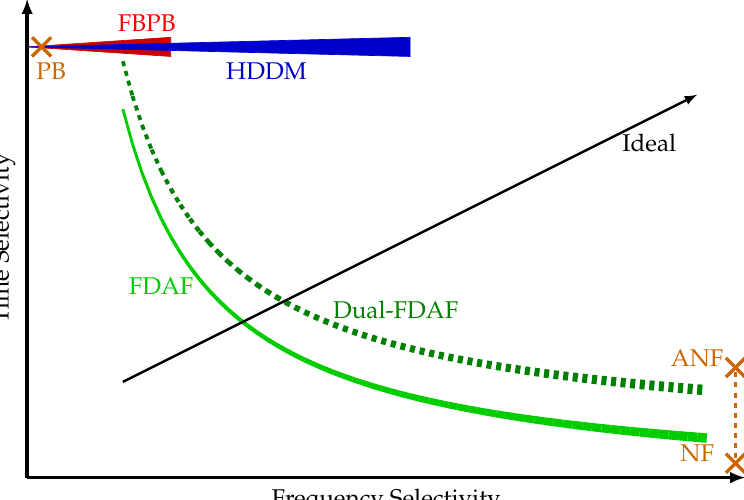
Figure 6. Conceptual comparison of mitigation algorithms, with the line thickness representing the computational complexity of different algorithms. Single points are relatively simple algorithms where the complexity is not indicated. This symbolic plot serves to provide an intuitive understanding of the different